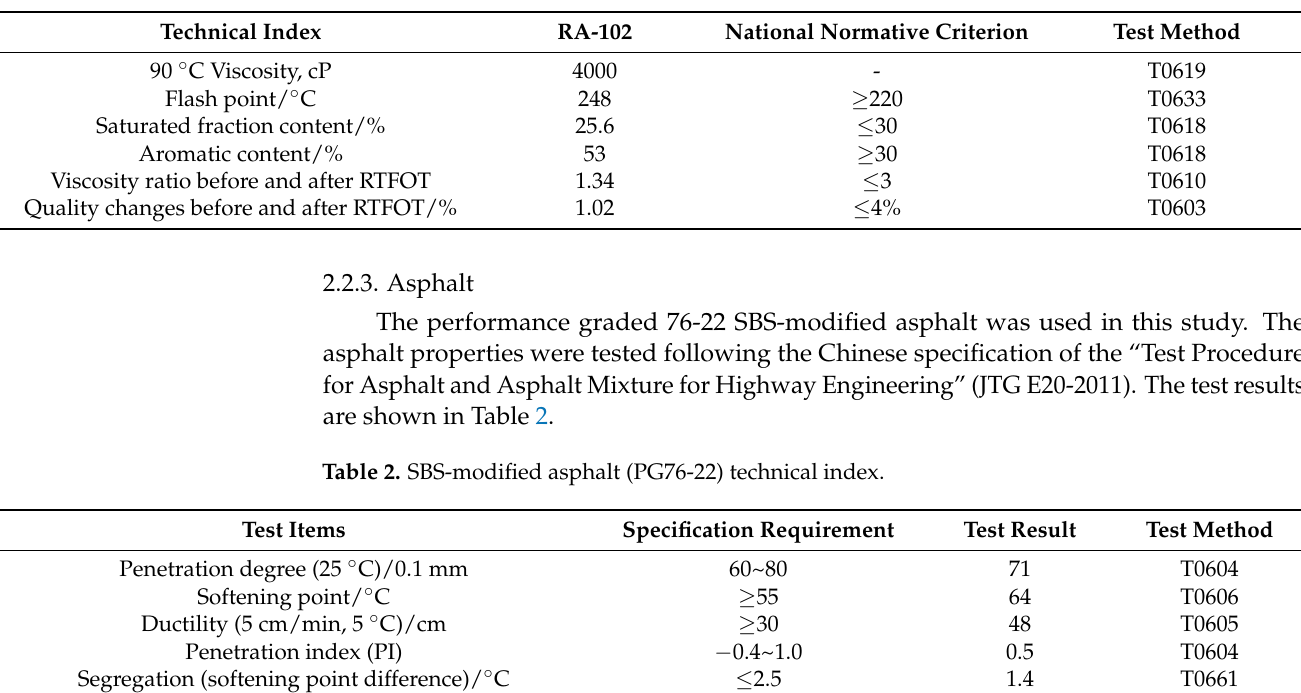
Table 1. Technical index of Subtherm RA-102 Recycling agent.